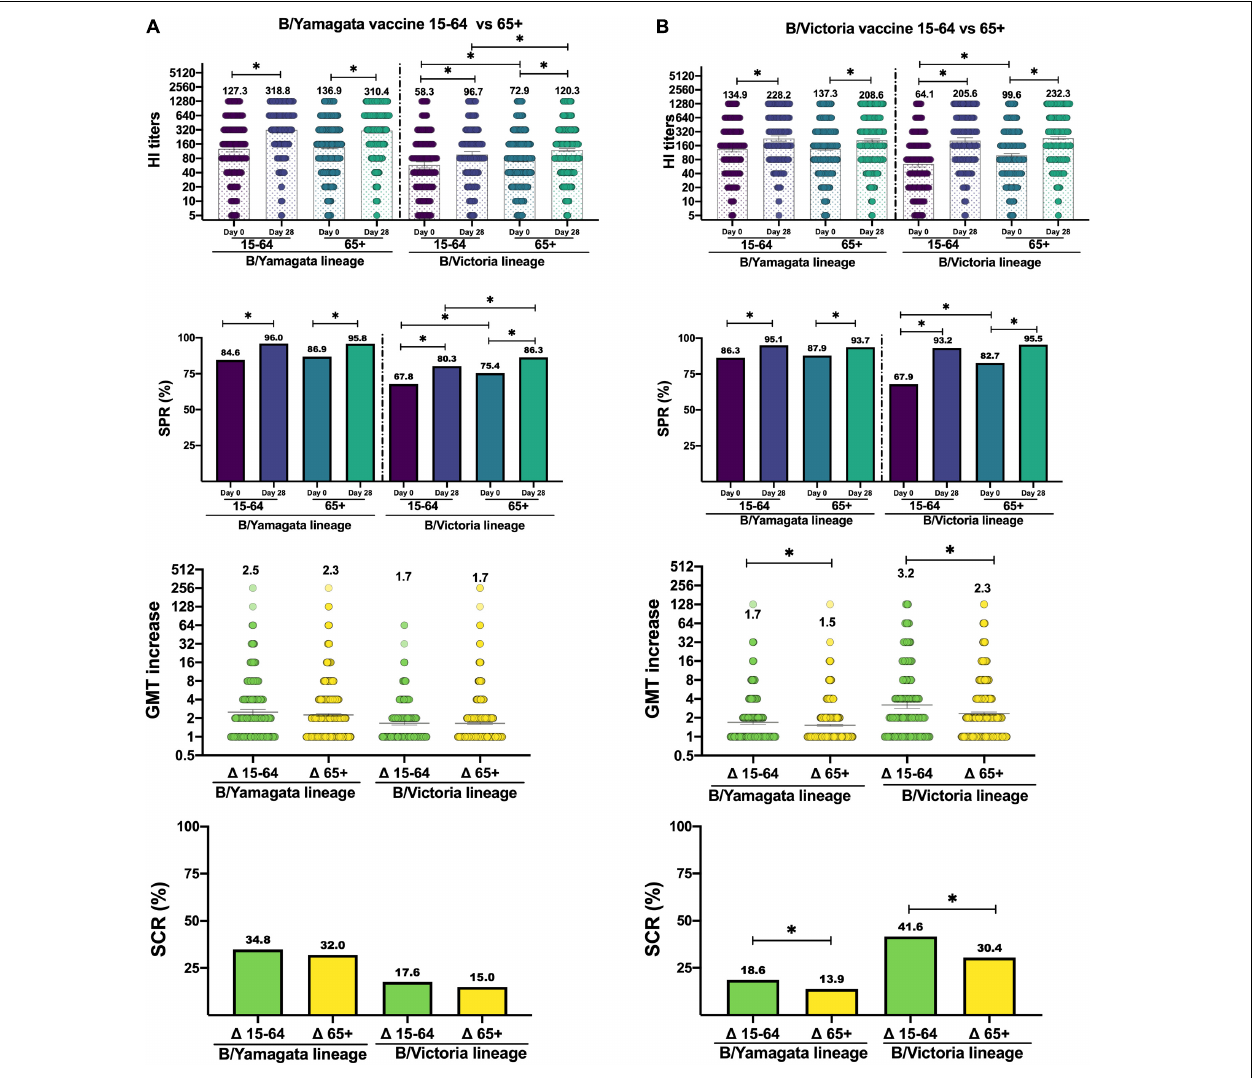
FIGURE 1 | Values of hemagglutination titers, seroprotection rate (SPR), GMT increase (GMTi) and seroconversion rate (SCR). (A) Response to B/Yamagata vaccine in different age groups. (B) Response to B/Victoria vaccine in different age groups. Significant differences ( p < 0.05) are marked with ∗